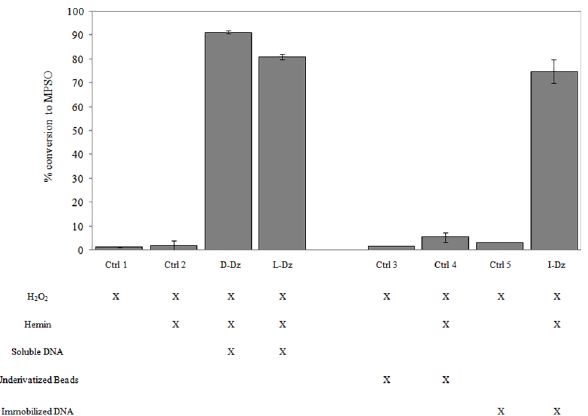
Fig 4. Oxidation of thioanisole using immobilized DNAzyme (I-Dz). Concentration of products was measured after 30 minutes and percentage of conversion was calculated in relation to the initial thioanisole concentration in the liquid phase.